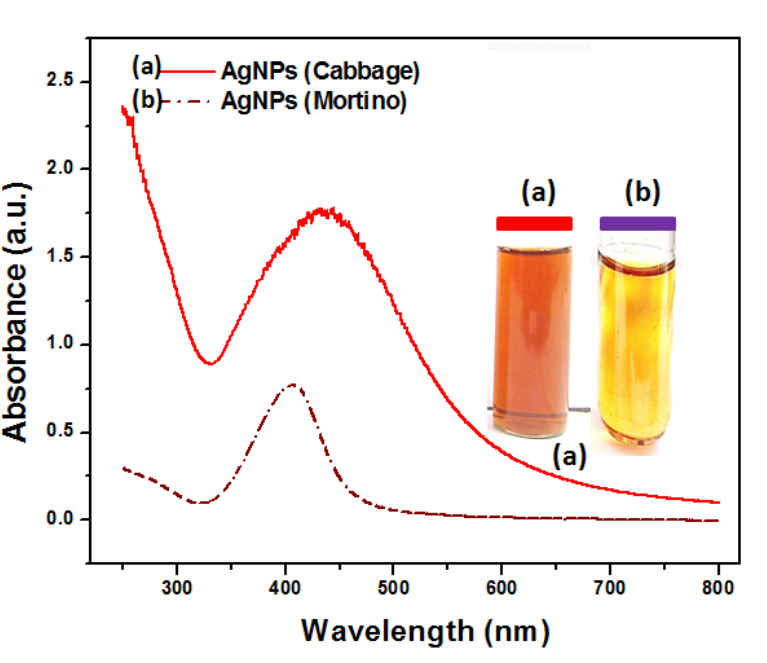
Figure 5. Visual and UV-Vis spectrum of silver nanoparticles synthesized using ( a ) Cabbage and ( b ) Mortino berry extract. ( b ) Mortino berry